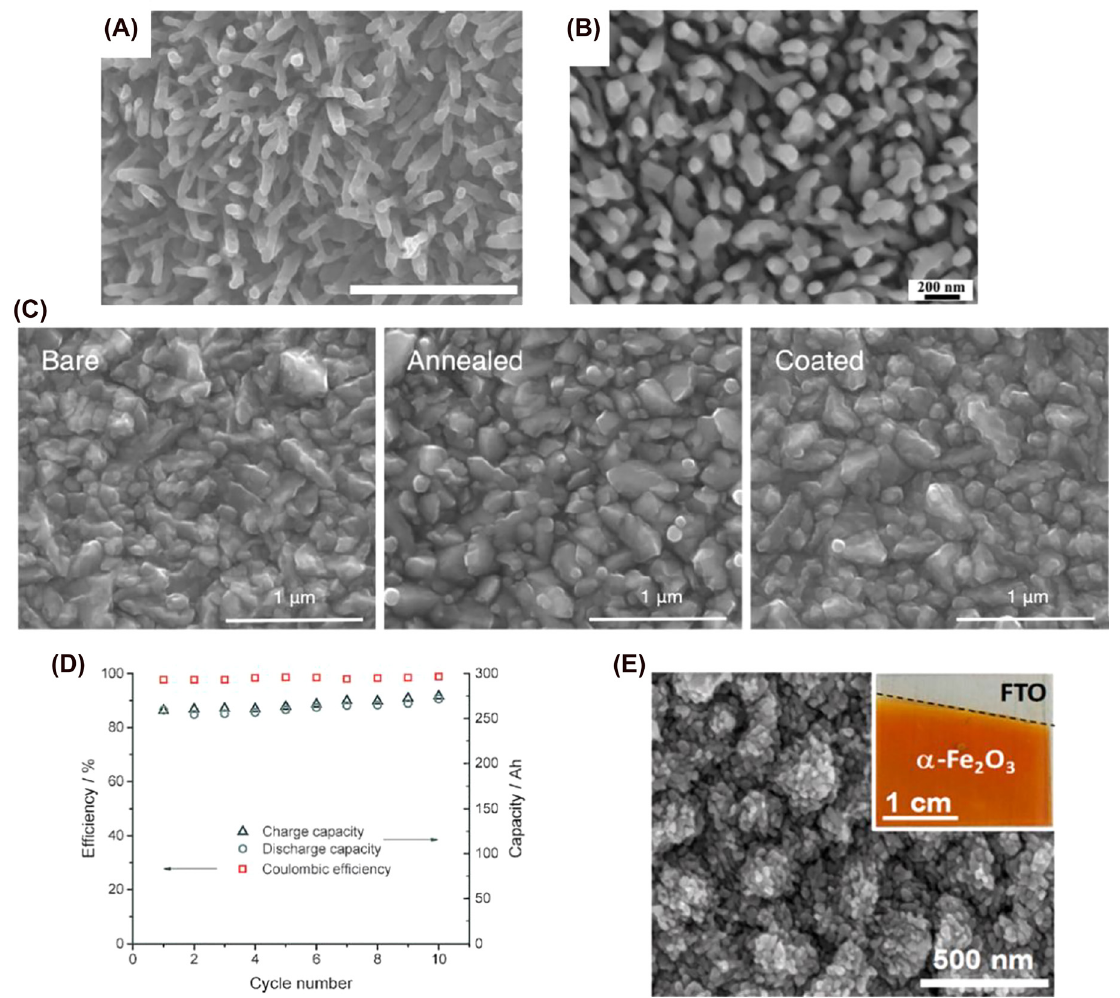
Figure 5: Structure and performance of hematite-based